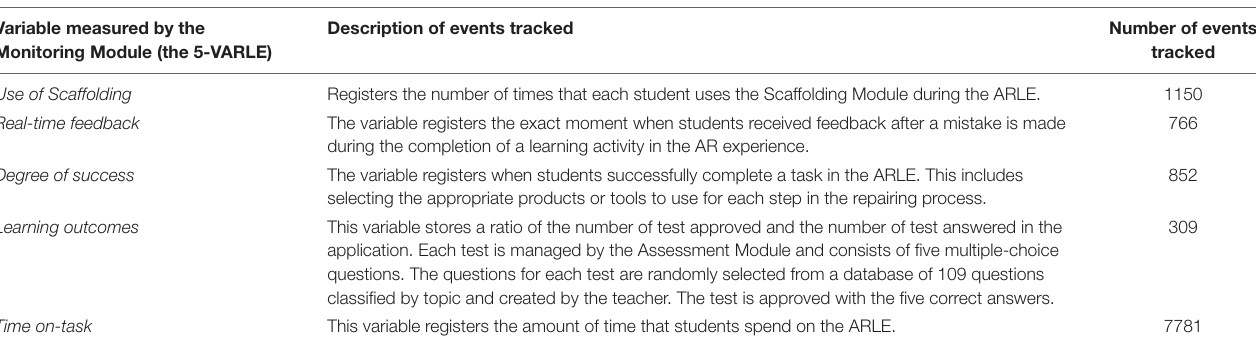
TABLE 4 | Events measured in the